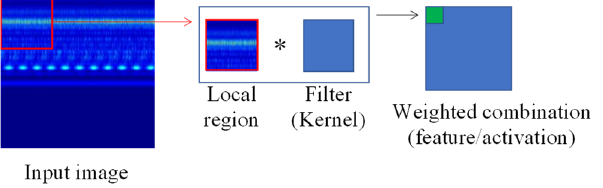
Figure 6. Illustration of convolution operation of a single filter on a single patch of the image. The filter is an array of weight and biases which is multiplied with a patch of the image to obtain a weighted combination (scalar value) of that region of the input. The filter is applied multiple times to the input image and this results in a filtered image at the output, often referred to as the activations, or feature map, of that filter. There are as many filtered images at the output of a convolutional layer as the number of filters in that layer, and the filtered images are arranged in the form of three-dimensional array. The third dimension of the convolutional output is known as the number of channels. A typical example of output from the first convolutional layer of the deep learning model of Table 3 is shown in Figure 7. Figure 7. An example of the feature map realized by 16-filter of the 1st convolution layer. Herein, it is observed that each filter is realizing different features of the input image, which are supplied to the next layers for further processing. The convolution process is mathematically described by Equation (8).